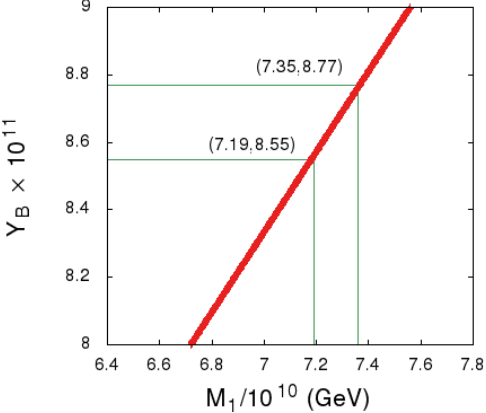
Figure 4 . Y B vs. M 1 curve corresponding to (cid:31) 2